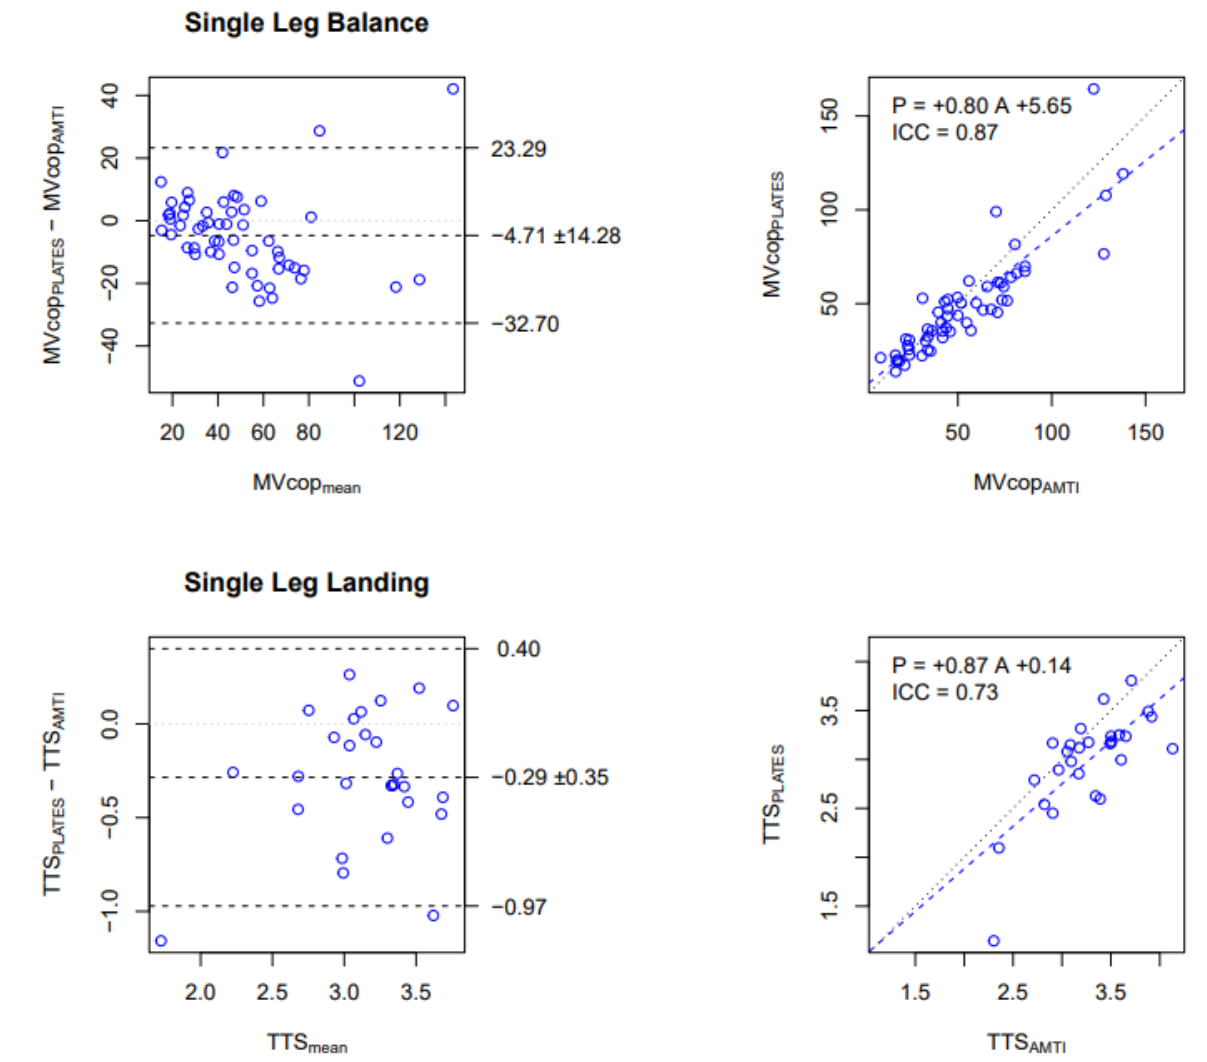
Figure 4. Comparison of MVcop and TTS obtained with PLATES-Field vs. AMTI-Laboratory. Upper row: MVcop for the Single Leg Balance test (mm/s). Lower row: TTS for the Single Leg Landing test (s). Left column: Bland and Altman plot. The central horizontal line indicates the mean of the differences (systematic bias), which is 0 for perfect agreement. The horizontal lines above and below represent the 95% limits of agreement. Right column: Linear regression. Data from all conditions are reported (i.e., 14 participants × 4 conditions for SLB, 14 participants × 2 conditions for SLL). Each dot corresponds to the average over the 3 repetitions in each condition. The figures show that MVcop and TTS are reliably assessed in the field with PLATES, although with a small underestimation (negative bias in Bland and Altman) that is proportional to the value (slope lower than 1 in the